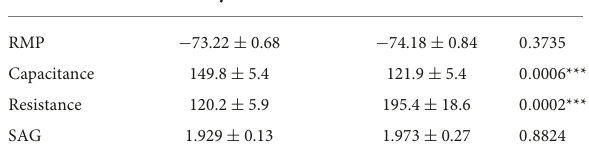
TABLE 2 Electrophysiological properties of VTA-projecting ACC